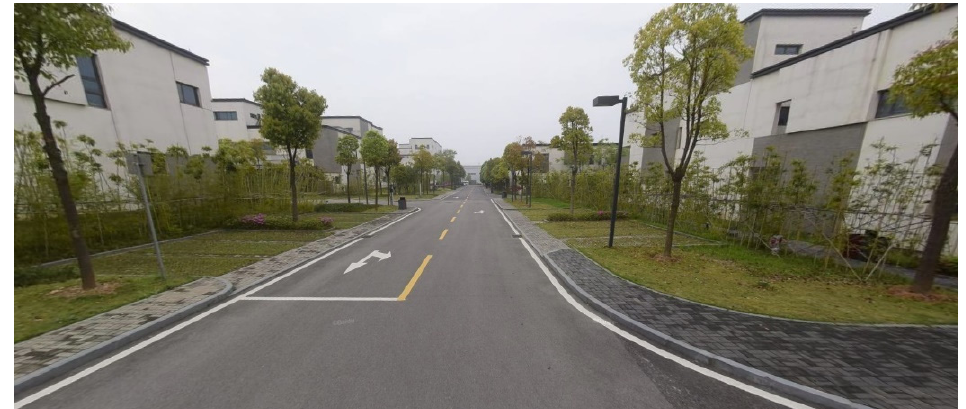
Figure 7. Wuhan Research and Innovation Center from Baidu Street View.